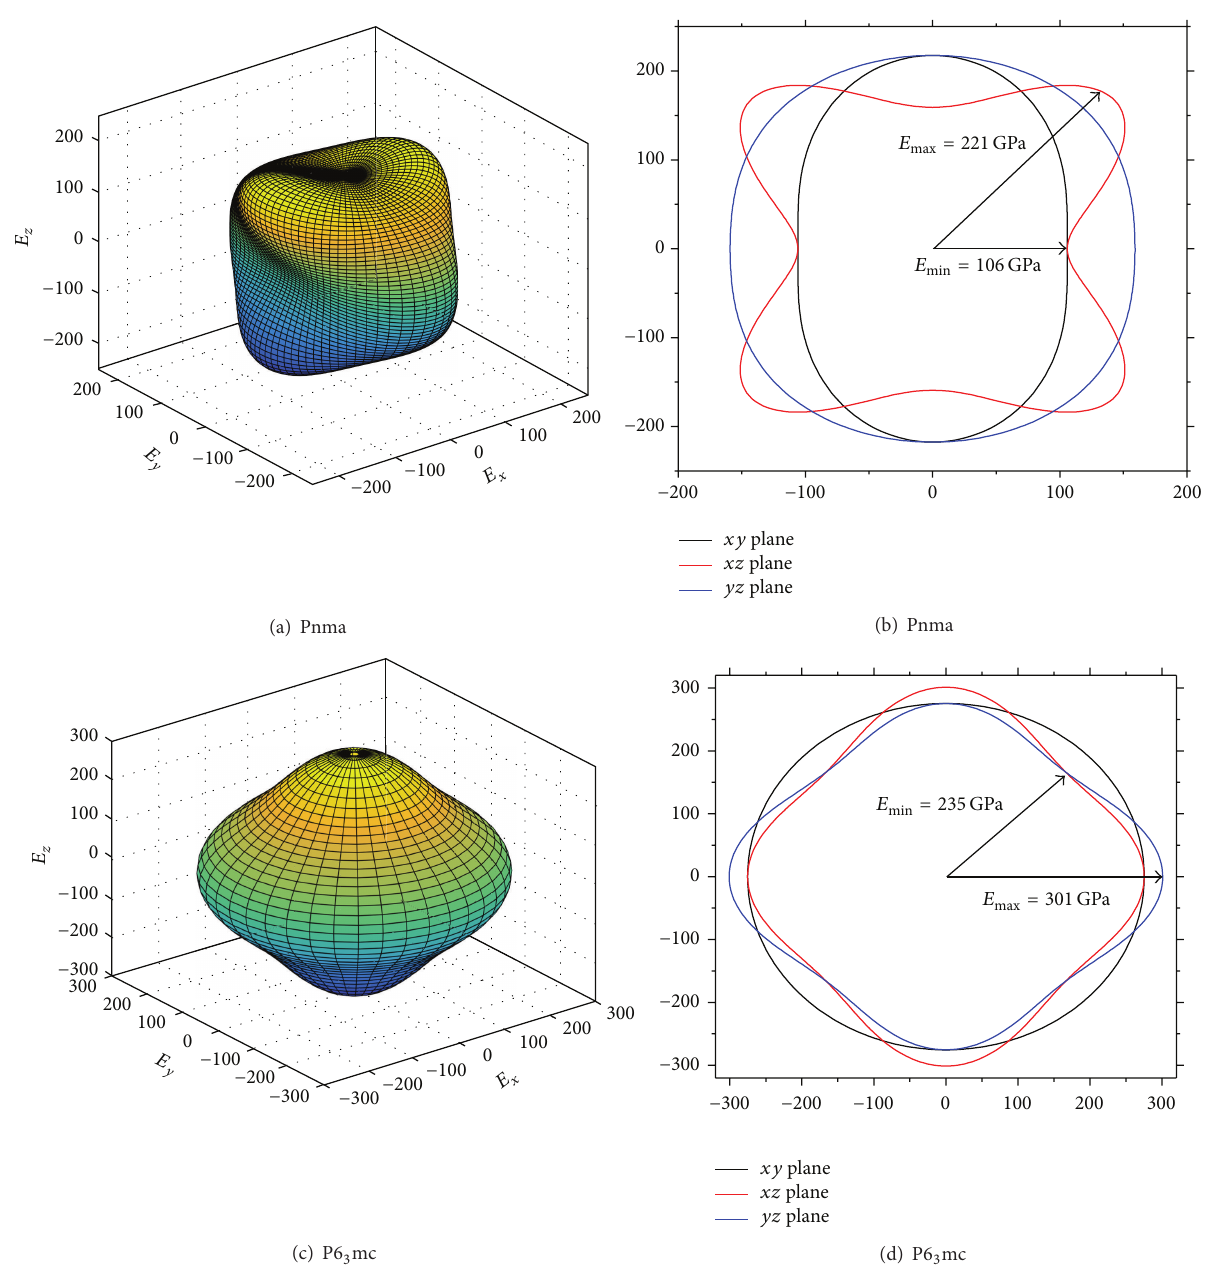
Figure 3: The directional dependence of Young’s modulus for Pnma-GaN (a), 2D representation of Young’s modulus for Pnma-GaN in the 𝑥𝑦 plane, 𝑥𝑧 plane, and 𝑦𝑧 plane (b). The directional dependence of Young’s modulus for wurtzite-GaN (c), 2D representation of Young’s modulus for wurtzite-GaN in the 𝑥𝑦 plane, 𝑥𝑧 plane, and 𝑦𝑧 plane (d). The units of axes are all in GPa.